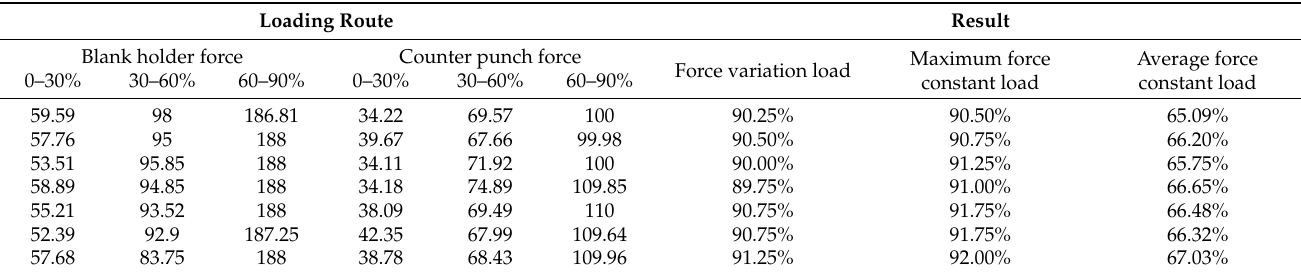
Table 8. Comparison between different loading